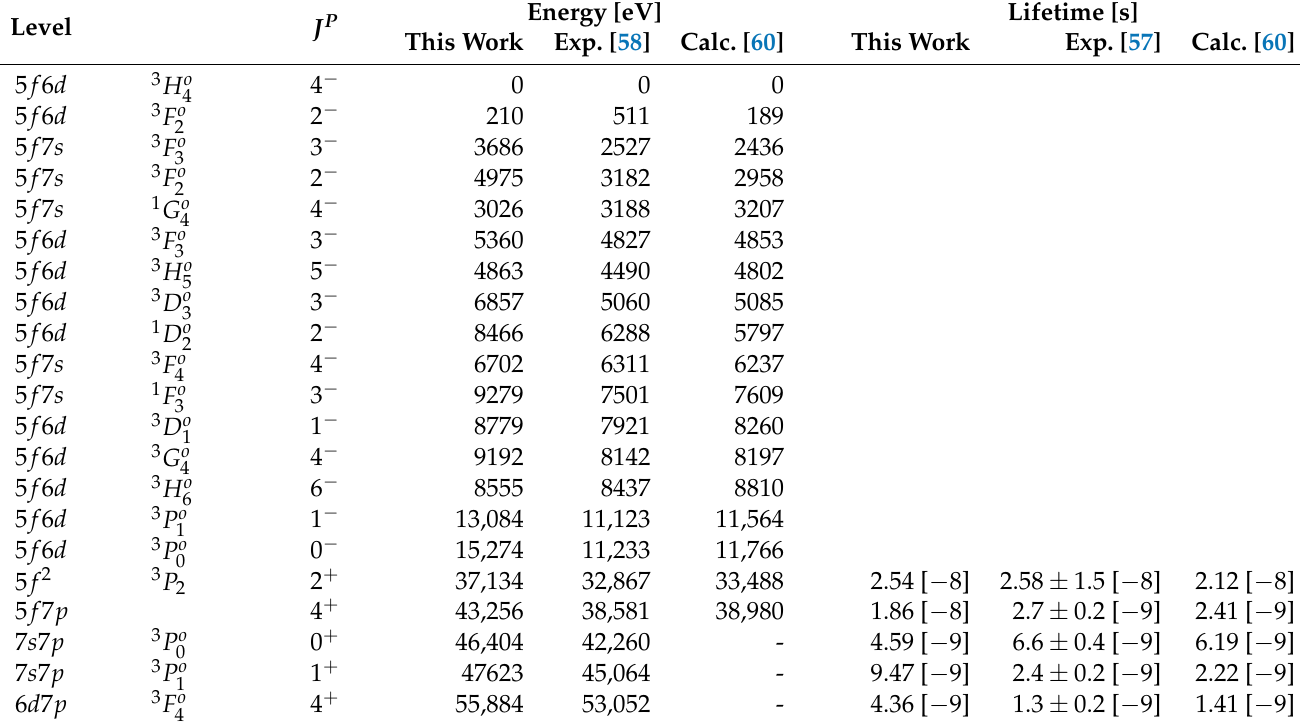
Table 3. Excitation energies [eV] and lifetimes [s] of Th 2 + . Data from the J AC toolbox are compared with the NIST database ([58]), experiments and previous computations. Results are shown for 16 low-lying levels. These energetically low-lying levels can be identified uniquely using their energy and total symmetry despite of certain level crossings. In general, strong admixtures of other LSJ symmetries are typically found for these levels, which increase further as the valence-shell structure is “opened” further. See text for